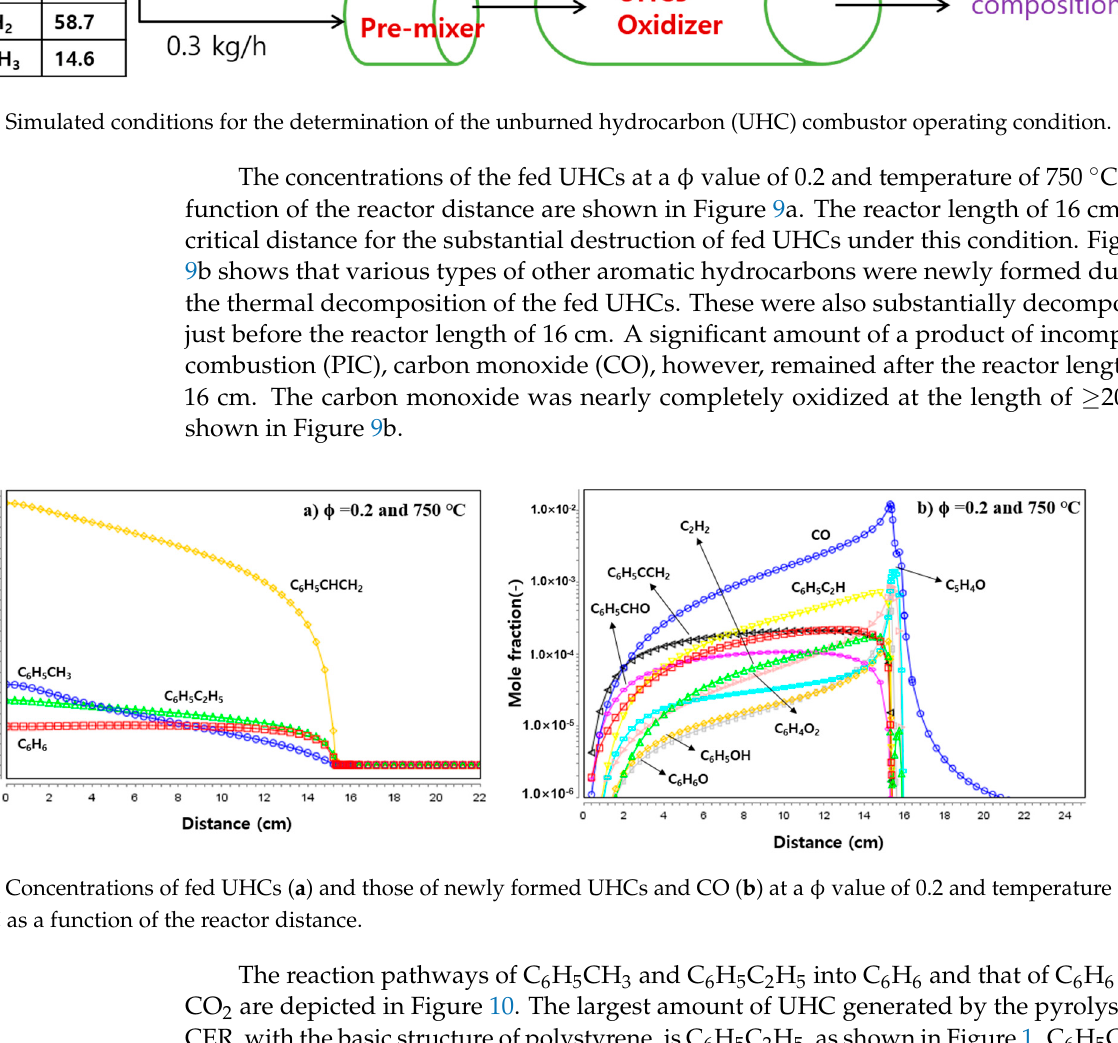
Figure 10. Reaction pathways of C 6 H 5 CH 3 ( a ) and C 6 H 5 C 2 H 5 ( b ) into C 6 H 6 , and that of C 6 H 6 ( c ) into CO 2 .